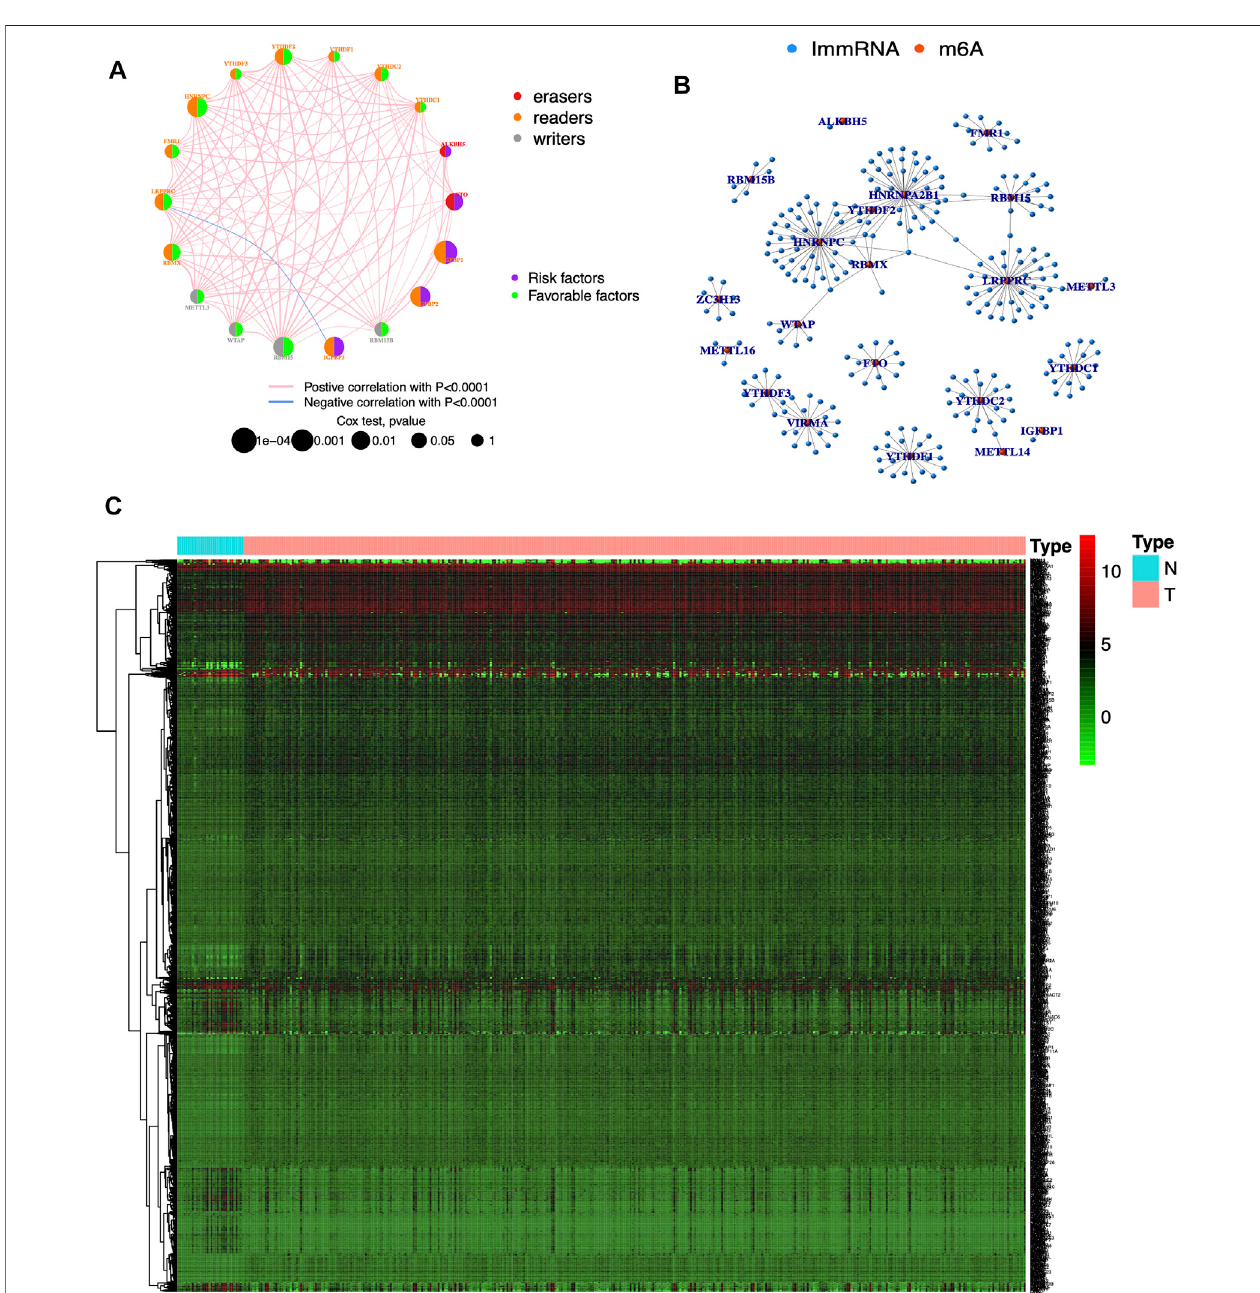
FIGURE 2 | Visualization of m6A regulatory and immune genes (A) Prognostic network diagram of m6A. Nodes represent m6A regulatory genes, blue signi fi es negativeco-expressionrelationshipsandredsigni fi espositiveco-expressionrelationships (B) Co-expressionnetworkofm6Aregulatoryandimmunegenes.Bluenodes signifyimmunegenes,rednodessignifym6Aregulatorygenes,andconnectinglinesrepresentco-expressionrelationships (C) Heatmap.Nrepresentsnormalgroups,T represents tumor groups. Green, black and red represent low, medium and high expressions respectively.